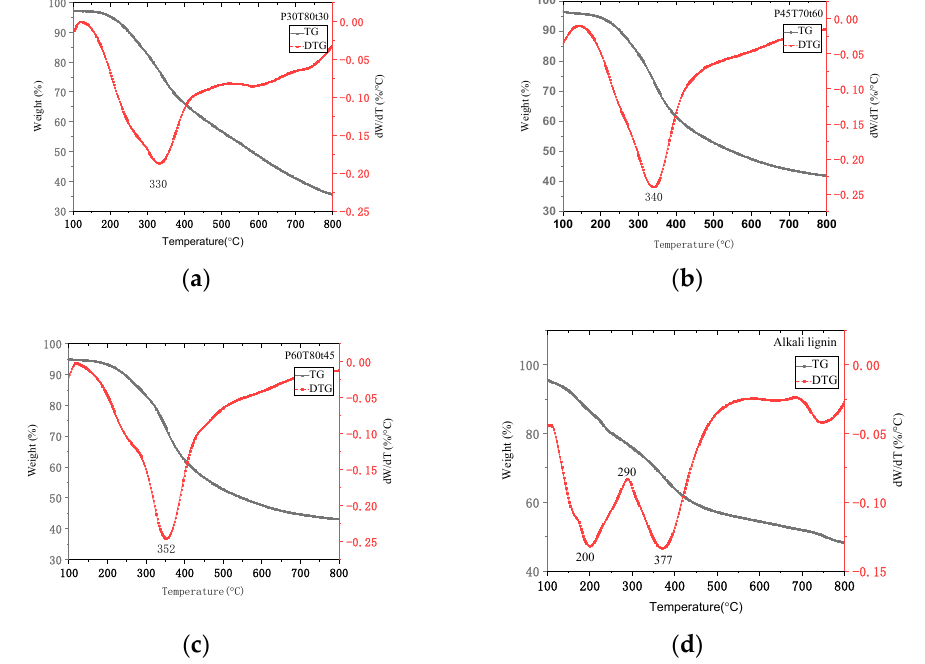
Figure 9. TG and DTG profile of selected lignin samples: ( a ) P30T80t30; ( b )P45T70t60; ( c ) P60T80t45; ( d ) Alkali lignin.